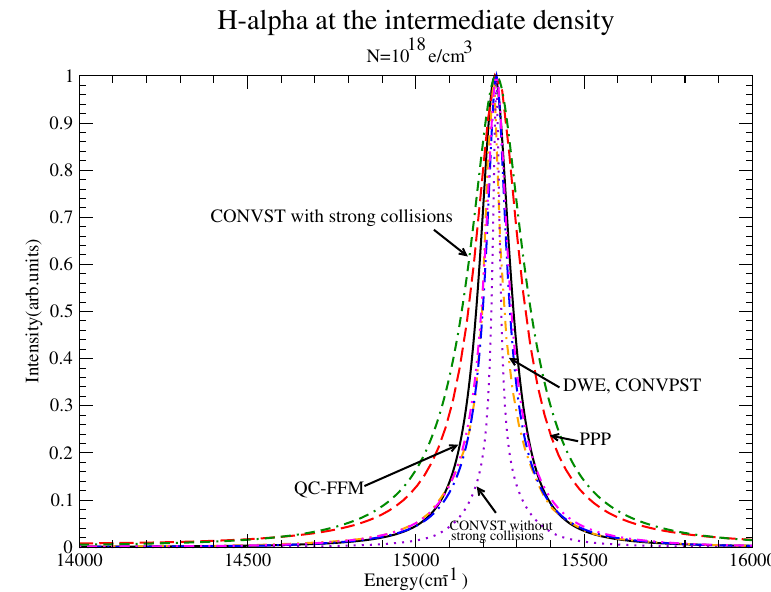
Figure 15. H α at the intermediate density showing a very good agreement between QC-FFM, CONVPST and DWE. Shown are QC-FFM (solid), PPP (dashed), DWE (dash-dotted), CONVST without strong collisions (dotted), CONVST with strong collisions (dot-double dashed), CONVPST without strong collisions (long dash-dotted) and CONVPST with strong collisions (dash-double